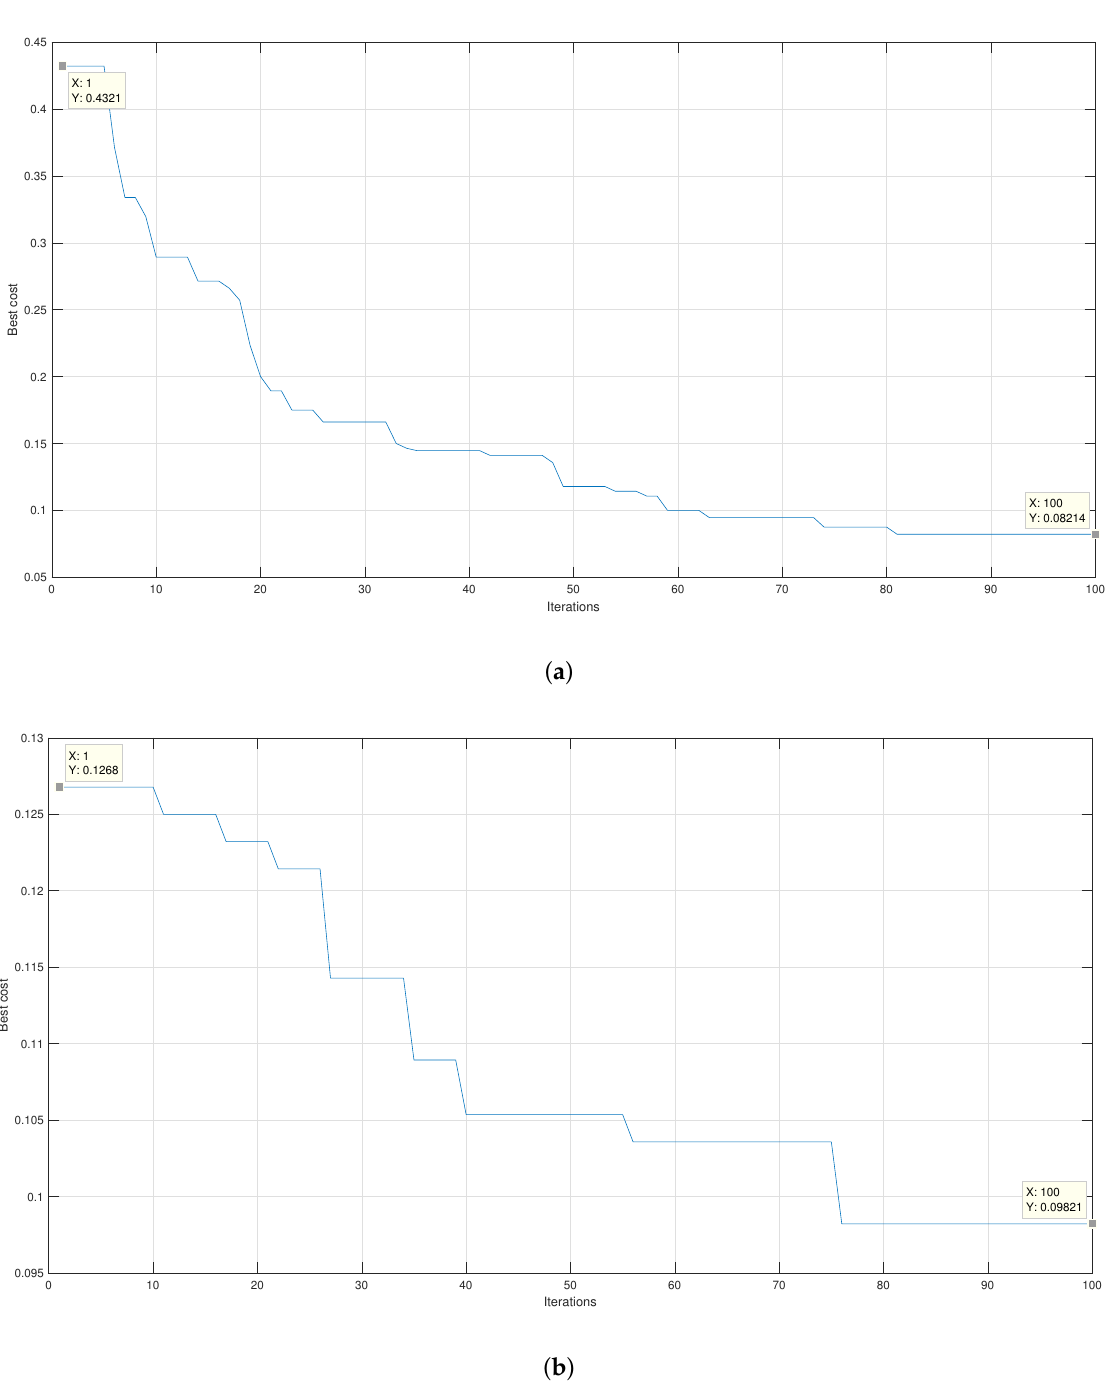
Figure 13. Results of the average error percentage for the training and validation of the final SVM with ( a ) Gaussian kernel and with ( b ) linear